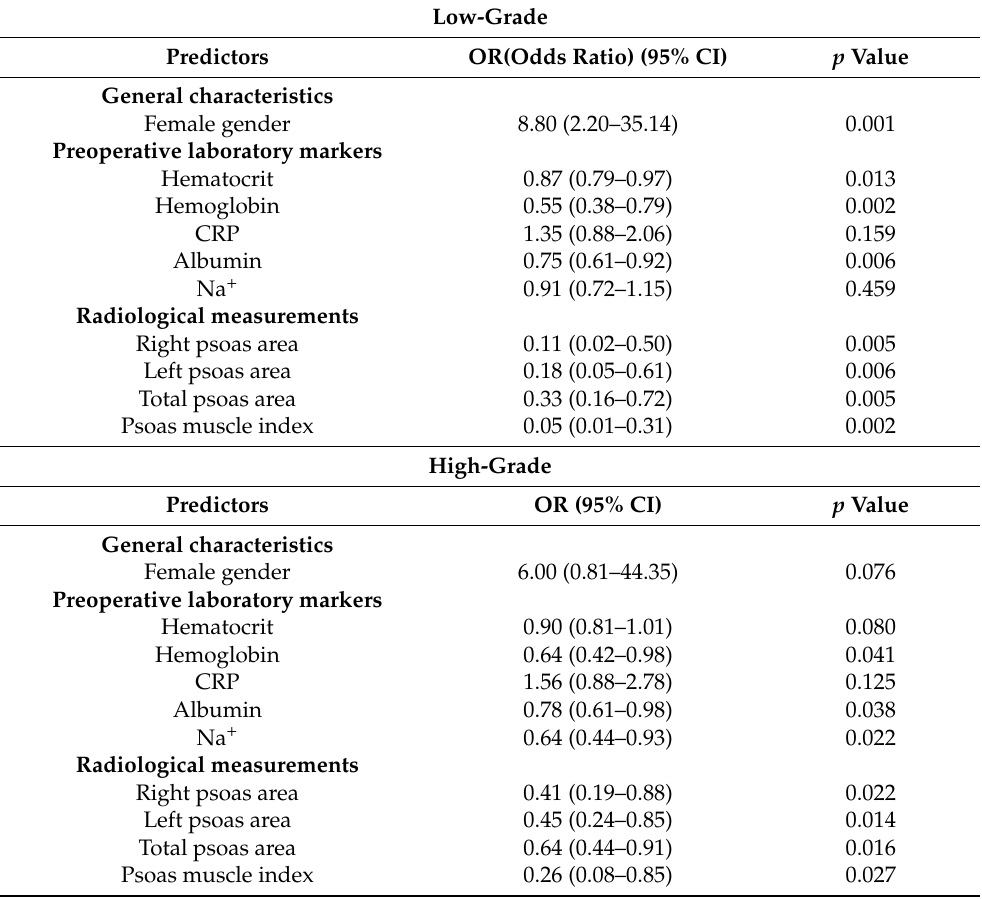
Table 5. Logistic regression analysis of risk factors for occurrence of complication vs. no